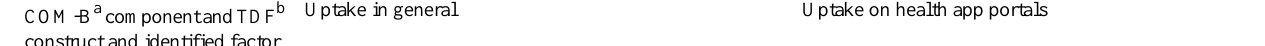
Table 1. Factors influencing uptake of health apps in general and on health app portals mapped onto the components of the Capability, Opportunity, Motivation-Behavior model and Theoretical Domains Framework